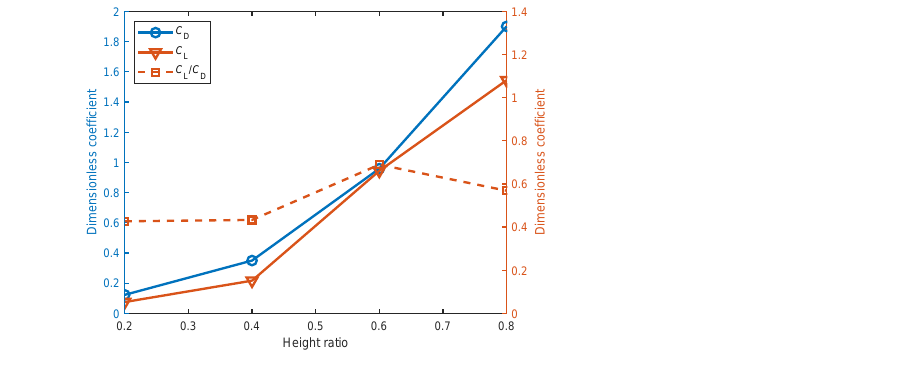
Figure 5. The variation of lift coefficient, drag coefficient and their ratio around AUH’s model versus its height-diameter ratio.